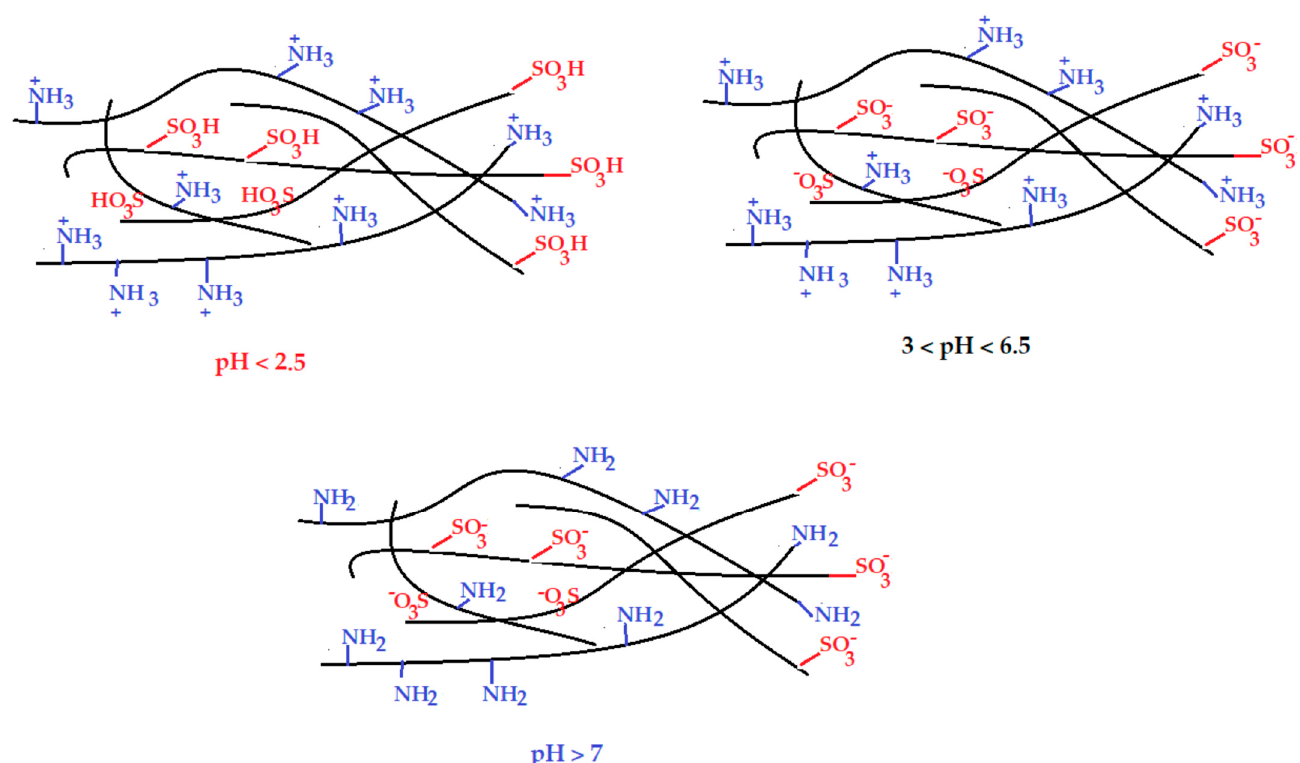
Figure 15. Scheme of the ionic charge of the functional groups of the composite membrane depending on the pH.